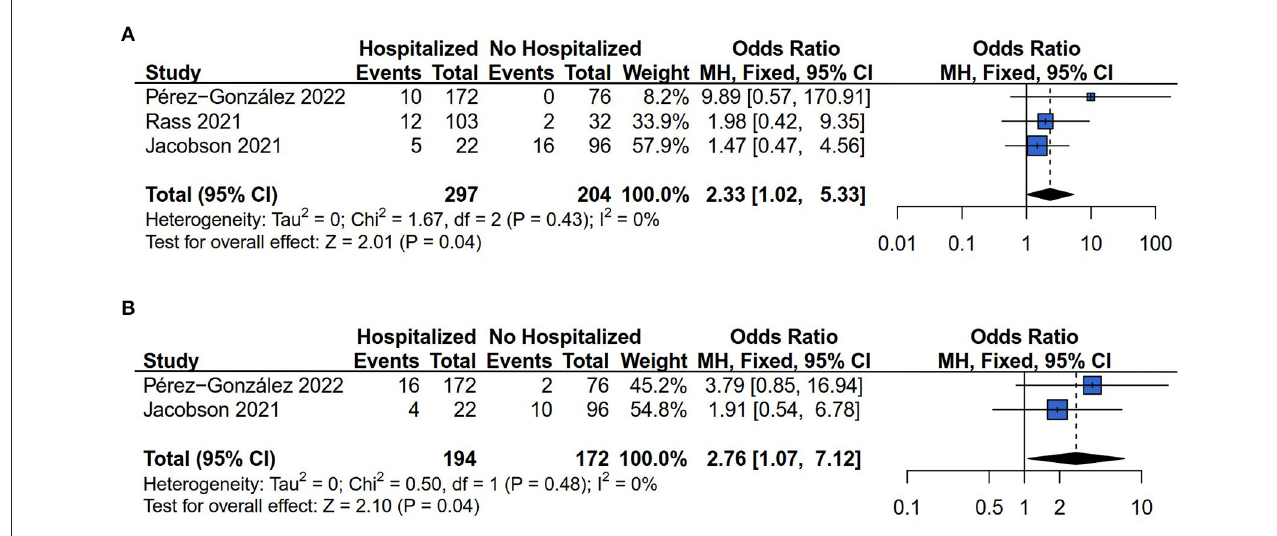
FIGURE6 Forest plot for meta-analysis of other symptoms risk among Hospitalized vs. non-hospitalized COVID-19 survivors. (A) Myalgia risk; (B) Hair loss risk.